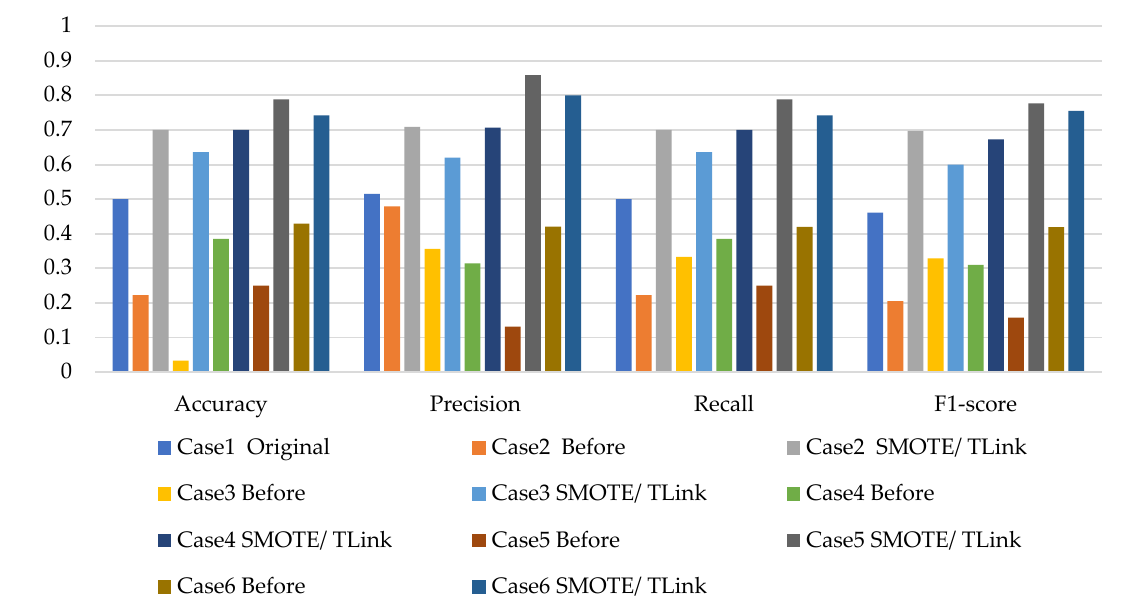
Figure 7. Simulation performance of NBC classification with SMOTE/T-link.